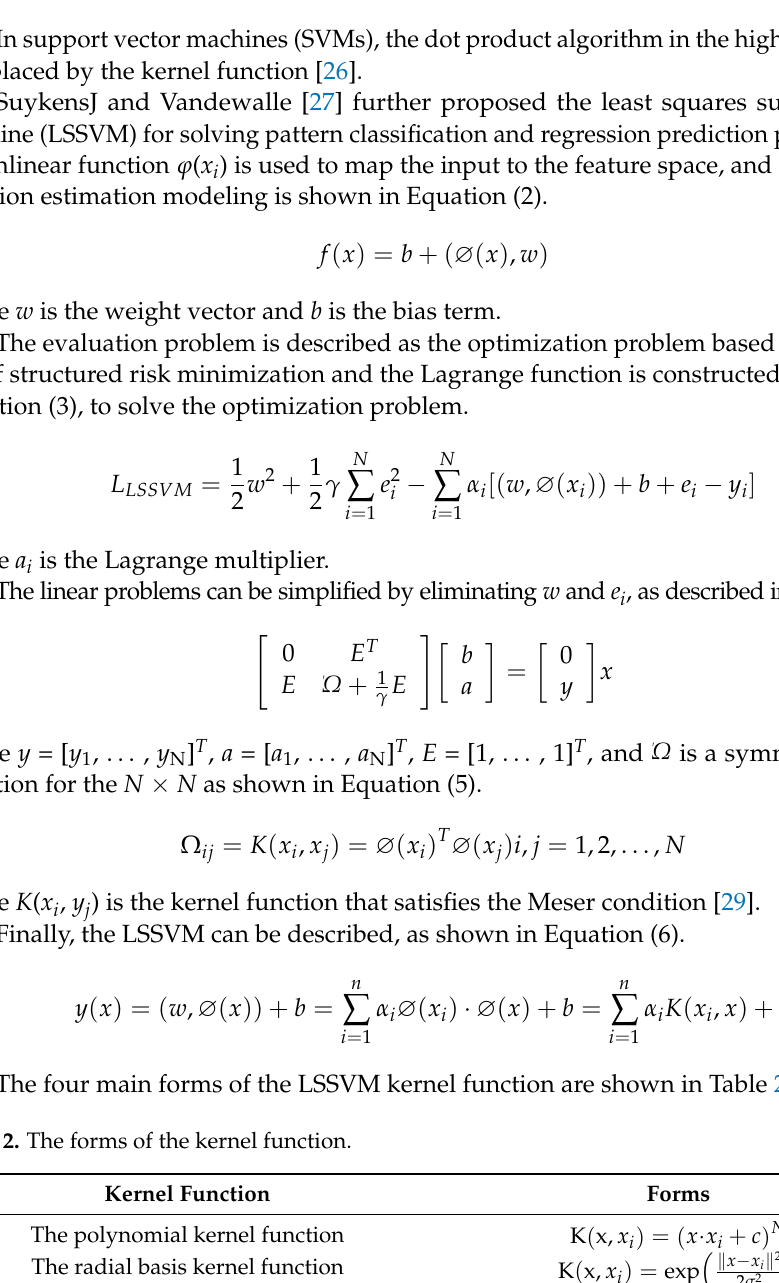
Figure 3. The PSO ‐ LSSVM fire warning algorithm model.